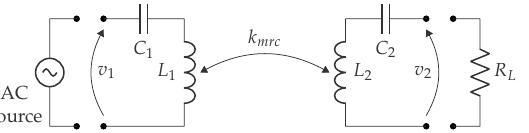
Figure 7. A series tuned primary and secondary LC-tank. The coupling factor k mrc in a magnetic resonance coupling system is typically lower than a coupling factor k m in an IPT